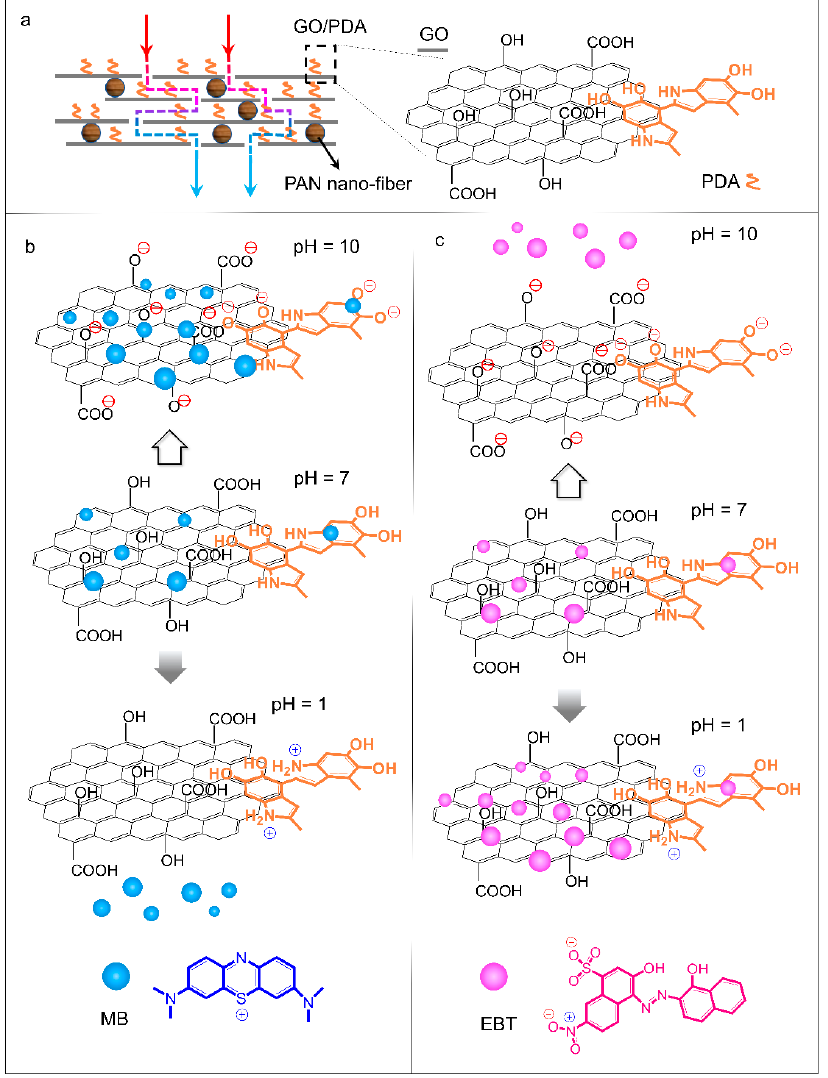
Figure 6. ( a ) Illustration of the construction of the PAN/GO/PDA membrane and the water- purification process. ( b ) Illustration of the pH-dependent adsorption–desorption mechanism of the PAN/GO/PDA membrane for cationic MB and ( c ) anionic EBT molecules. The pH-dependent adsorption–desorption behaviors towards MB and EBT exhibited by the PAN/GO/PDA membrane are attributed to its protonation and deprotonation effects [39]. In a neutral solution (pH = 7), both cationic MB and anionic EBT molecules can be adsorbed onto the surface of the PAN/GO/PDA membrane through π - π stacking. When the solution is changed for an alkaline solution (pH = 10), the -OH and -COOH groups from GO and PDA can be deprotonated, forming negative charge centers (-O − and -COO − ), while the MB molecule possesses two aromatic structures with positively charged sulphur atoms (S + ); thus, an electrostatic interaction can be produced between the PAN/GO/PDA membrane and MB molecules. This electrostatic force pushes MB molecules closer to the PAN/GO/PDA membrane, the two being eventually joined by π - π conjugation. Although EBT molecules also have aromatic structures, their negatively charged -SO 3 − groups repel the negative charge surrounding the PAN/GO/PDA